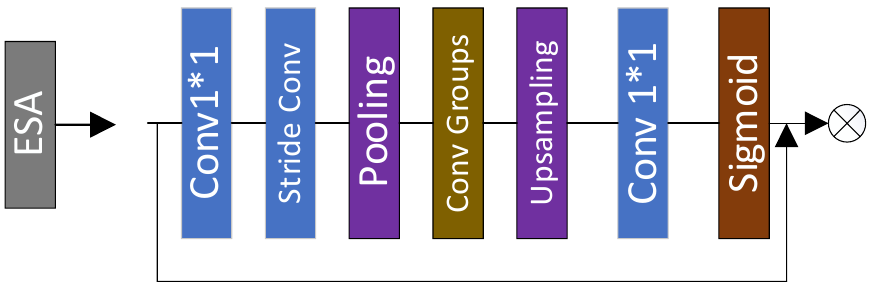
Figure 7. ESA module structure diagram.